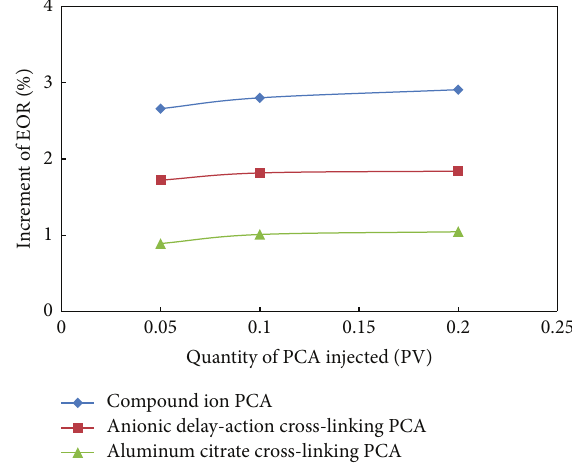
Figure 2: The relation between injected PV of PCA and recovery increment during polymer